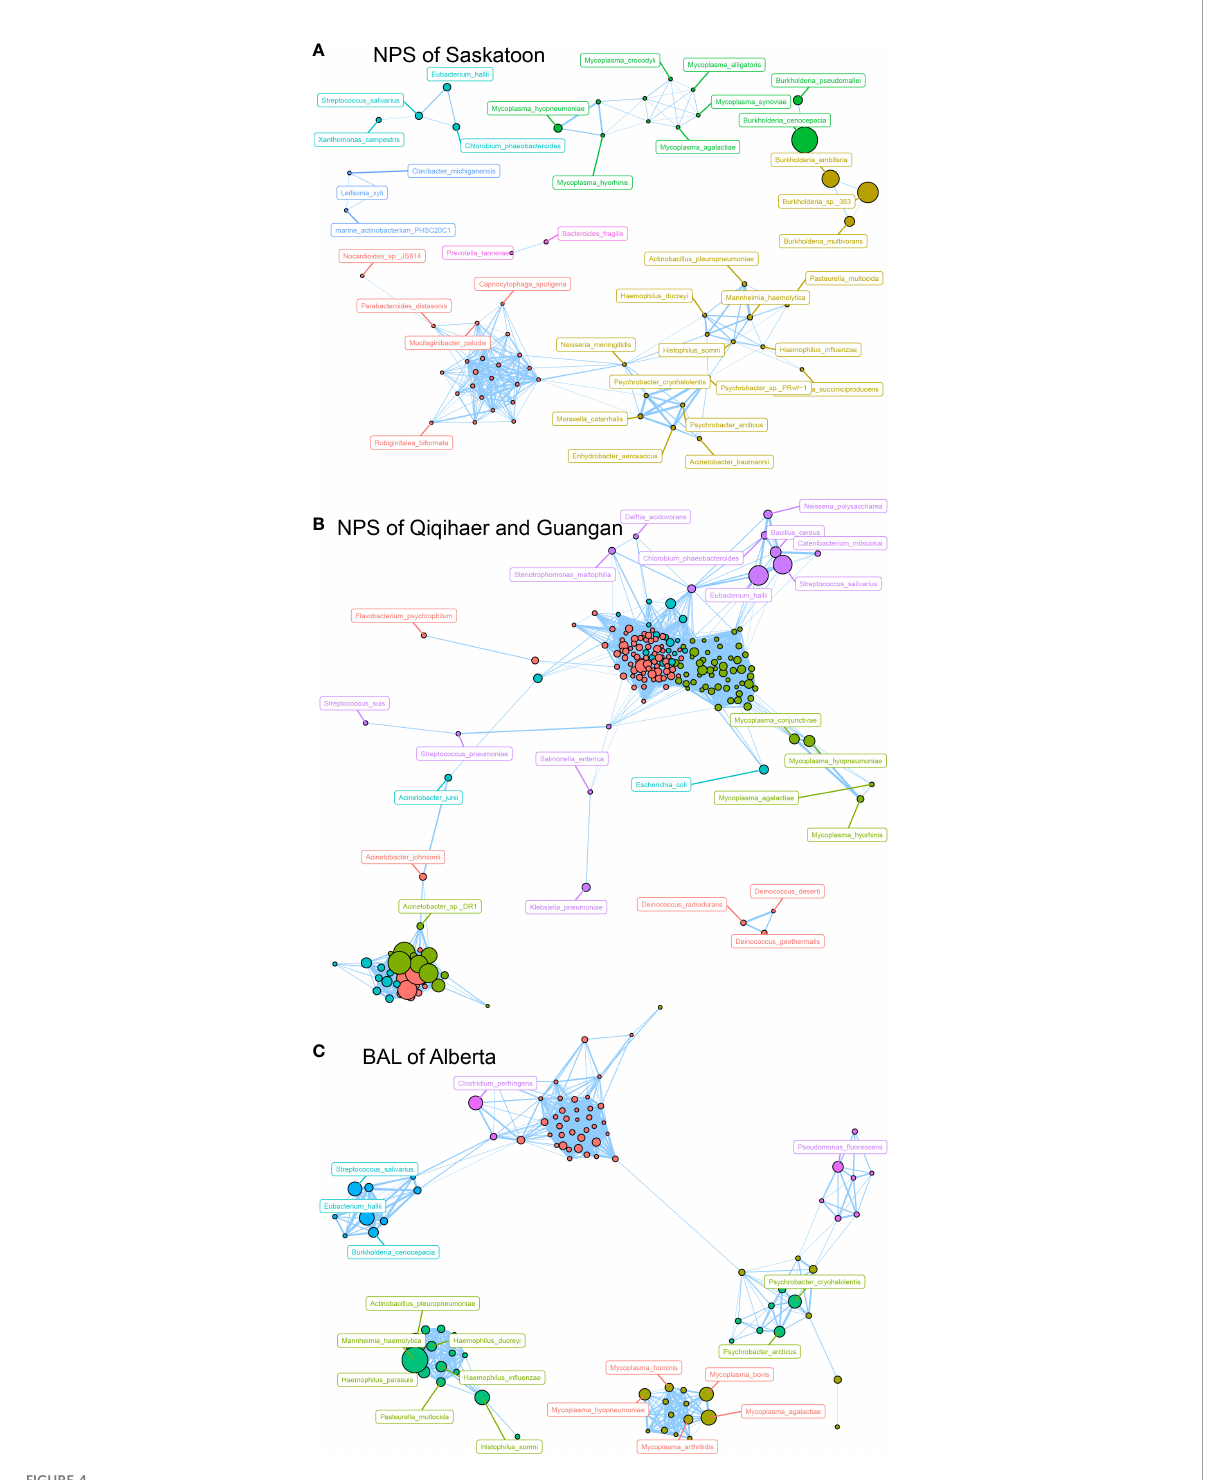
FIGURE 4 Network analysis revealing the co-occurrence patterns among airway microbial species. The nodes were colored according to modularity class. (A – C) Network analysis of bovine airway microbial species in samples of NPS of Saskatoon (Canada), NPS of Qiqihaer and Guangan (China), and BAL of Alberta (Canada). A connection represents a strong (Spearman ’ s correlation coef fi cient R > 0.8) and signi fi cant ( P < 0.01) correlation. The size of each node is proportional to the number of connections, that is, the degree. NPS, nasopharyngeal swab; BAL, bronchoalveolar